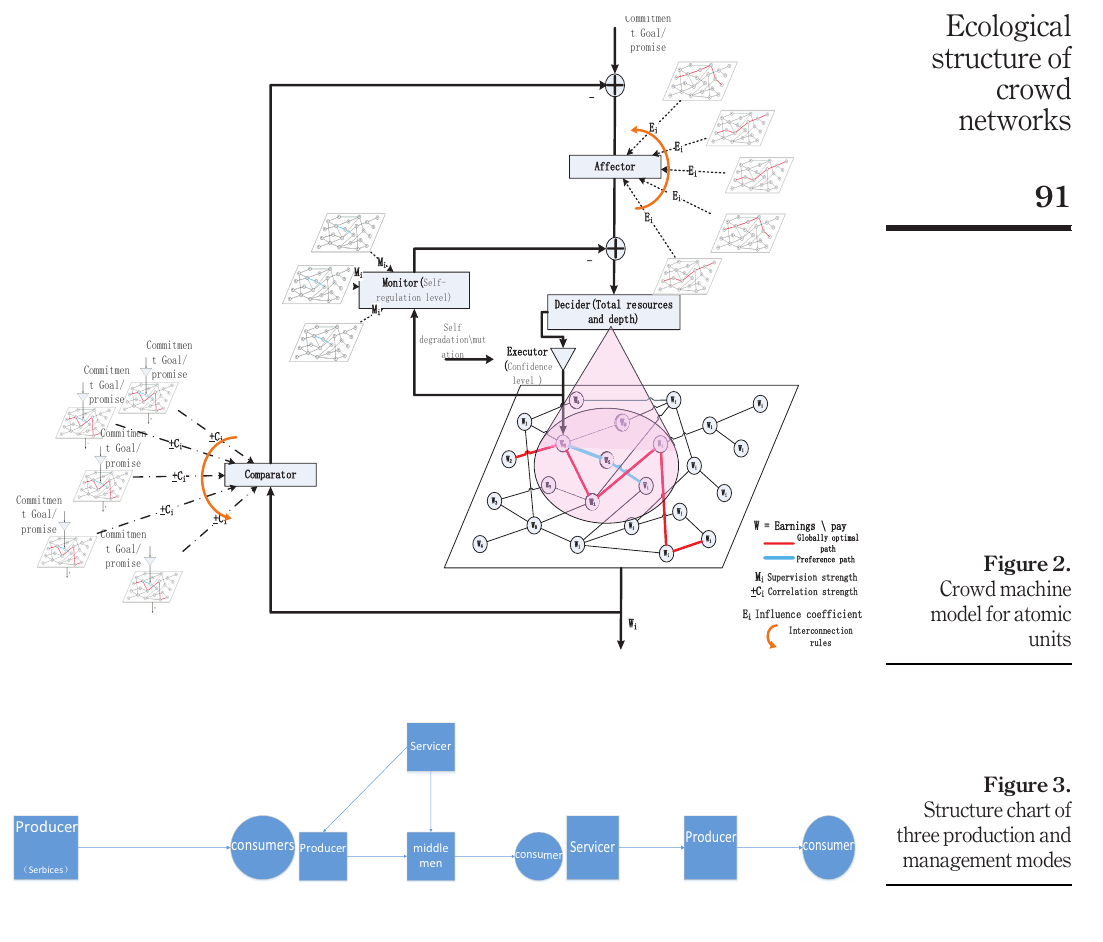
Figure 3. Structure chart of three production and management modes